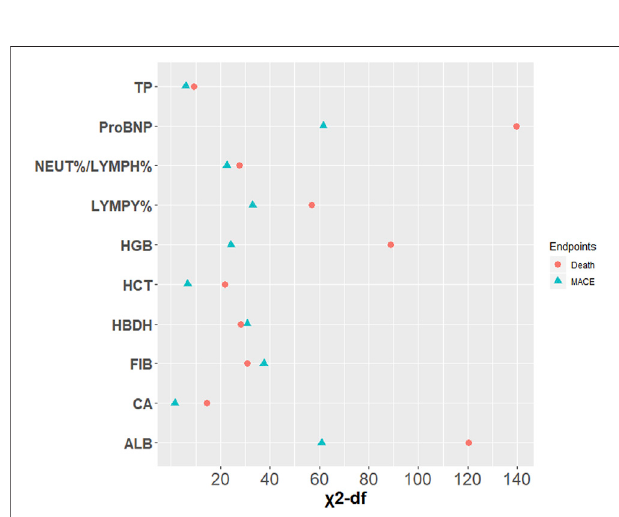
FIGURE 3 | Relative importance of each variable in the full model. Measured by partial Wald χ 2 minus the predictor degrees of freedom.